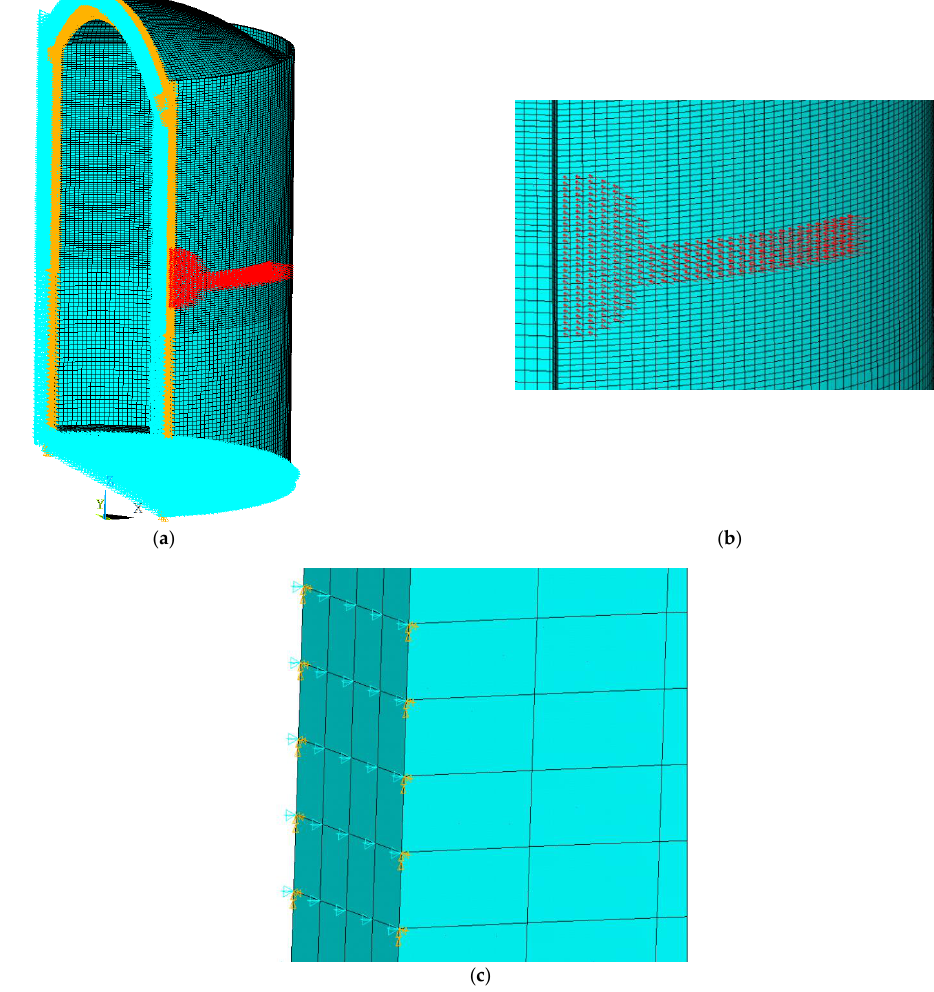
Figure 3. Finite element model of full SC containment. ( a ) Overall model; ( b ) Load area; ( c ) Symmetric restriction.